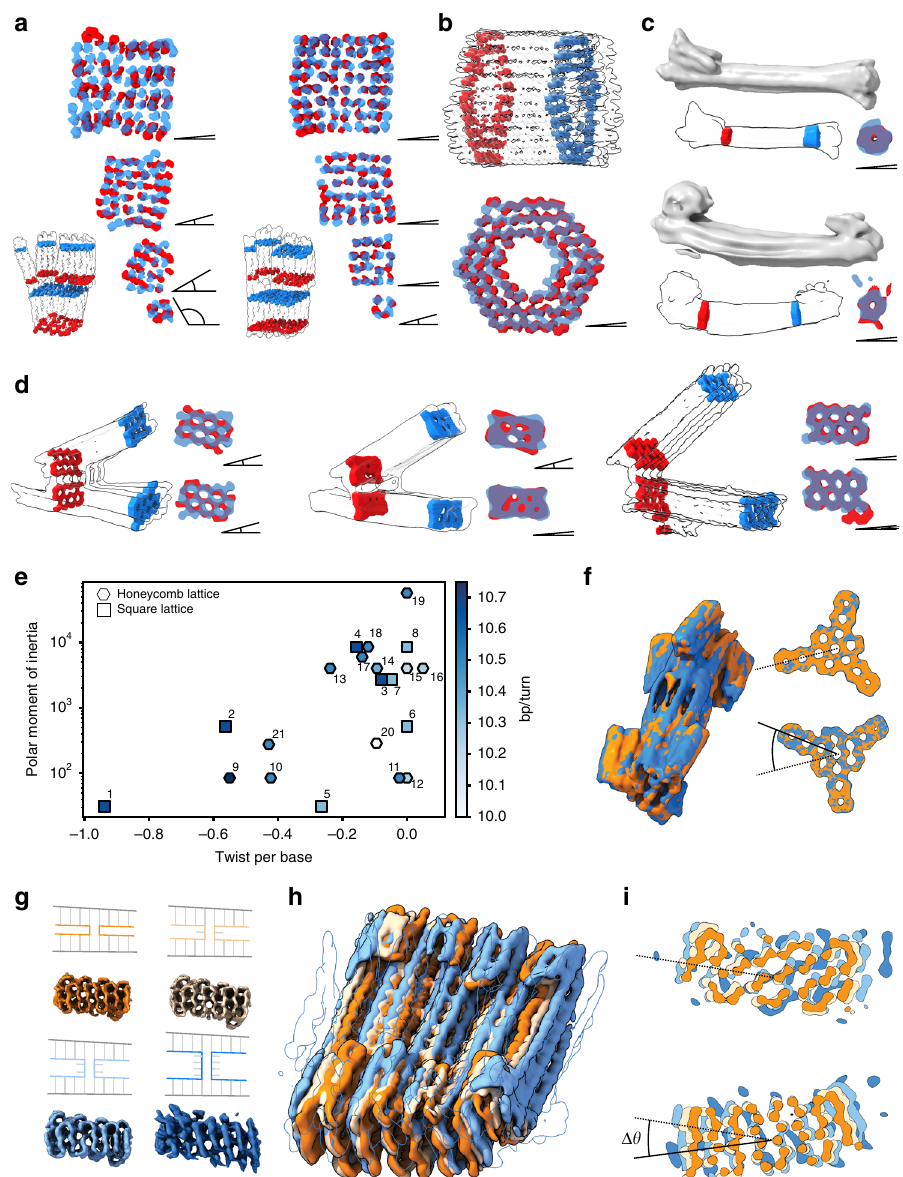
Fig. 2 Global shapes: twist, torsional stiffness, twist removal, and crossover strain. a Left versus right: cross-sectional slices of the cryo-EM maps of the four domains of the default Twisttower and twist-corrected Twisttower design variants, respectively. The angle symbol visualizes the amount of twist between the blue and red layers for a given subpart. Inset: the outline gives full cryo-EM map, the position of the cross-sectional slices are as indicated. b , c As in ( a ) but for the 126-helix bundle and for two six-helix-tube design variants. d Outlines and cross-sectional slices in cryo-EM maps of three twist- titrated variants of the hinged-beam object. e Symbols give a polar moment of inertia over the observed global twist per base pair in the 20 DNA origami cryo-EM maps. Colors indicate the effective helical twist density as imposed by design. 1 – 4: Twisttower 2 × 2, 4 × 4, 6 × 6, and 8 × 8 domains; 5 – 8: twist- corrected Twisttower 2 × 2, 4 × 4, 6 × 6, and 8 × 8 domains, respectively; 9 – 12: six-helix tubes v2, v3, v4, and v1, respectively; 13 – 16: hinged-beam-like objects v1, v2, v4, and v3, respectively; 17: 42-helix brick-like; 18: 48-helix brick; 19: 126-helix barrel-like; 20: 16-helix bundle; 21: ten-helix bundle. Source data are provided as a Source Data fi le. f Overlay of the cryo-EM maps determined from two dumbbell-like DNA origami objects. g Four DNA origami 48- helix-brick design variants with 0, 1, 2, 4 unpaired thymidines at all staple crossovers. h Overlay of the cryo-EM maps of the 48-helix-brick variants. i Cross sections of all four variants. Coloring as in ( g